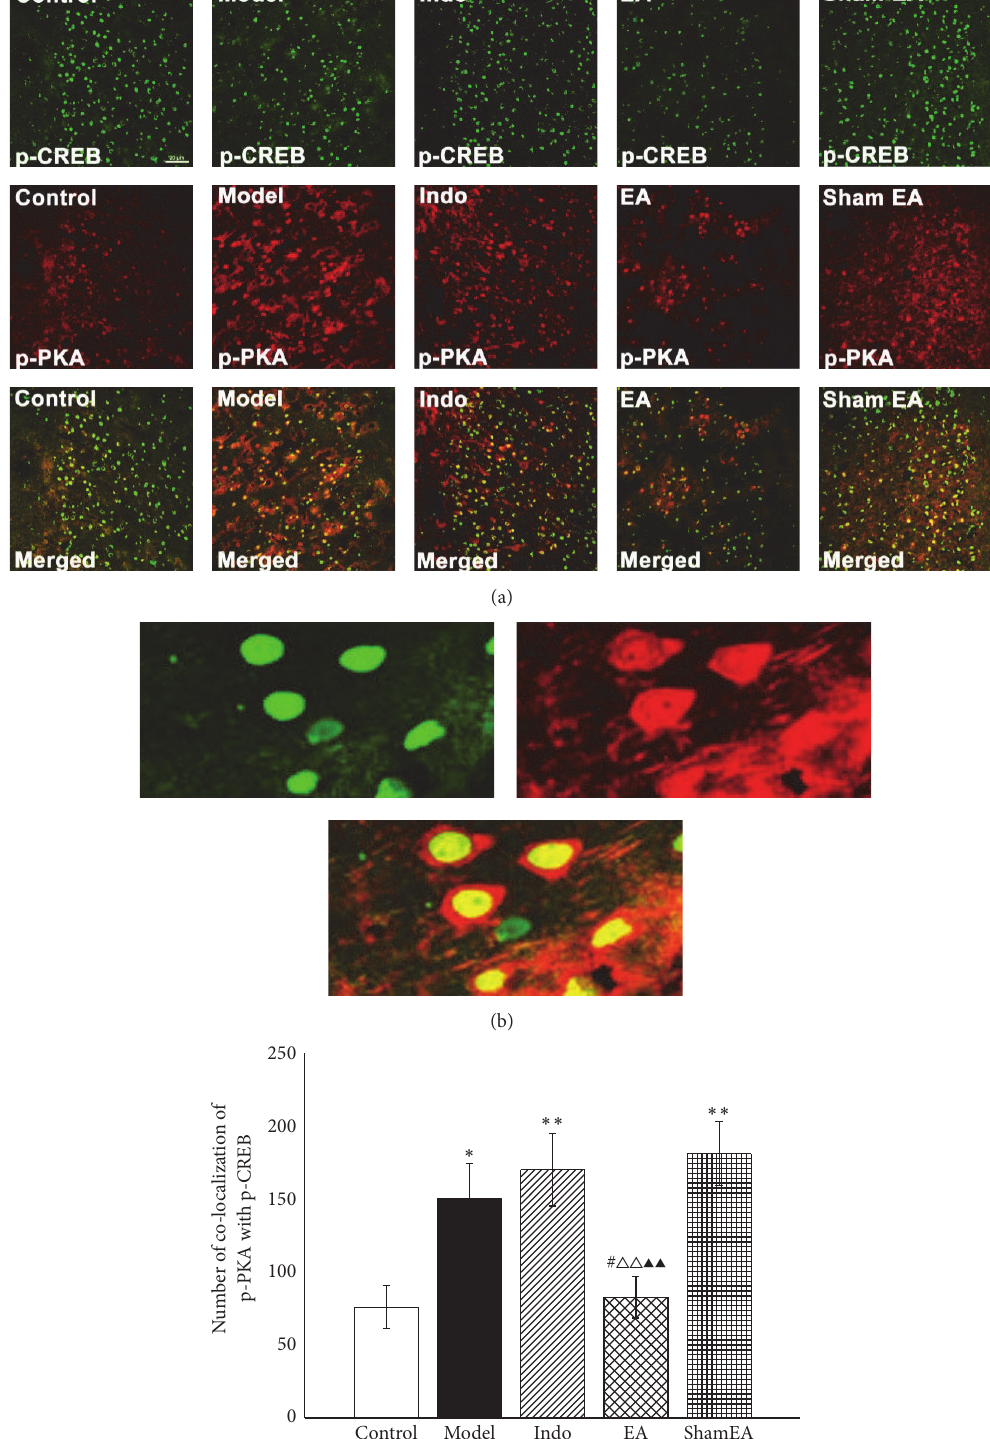
Figure 9: EA inhibited the colocalization of p-PKA with p-CREB in the ACC of pain memory model rats. The right ACC tissues from each groups were prepared and labeled with double-immunofluorescence ( 𝑛 = 3 , five slides for each rat). (a) Views of the colocalization of p-PKA with p-CREB (scale bar, 20 𝜇 m). (b) The magnified image shows the colocalization of p-PKA with p-CREB. (c) Double-labeled immunofluorescence analysis demonstrated that EA significantly reduced the numbers of colocalized p-PKA and p-CREB. Error bars indicated SEM. ∗ 𝑝 < 0.05 and ∗∗ 𝑝 < 0.01 , versus the control group; # 𝑝 < 0.05 , versus the model group; △△ 𝑝 < 0.01 , versus the indo group; 󳵳󳵳 𝑝 < 0.01 , versus the sham EA